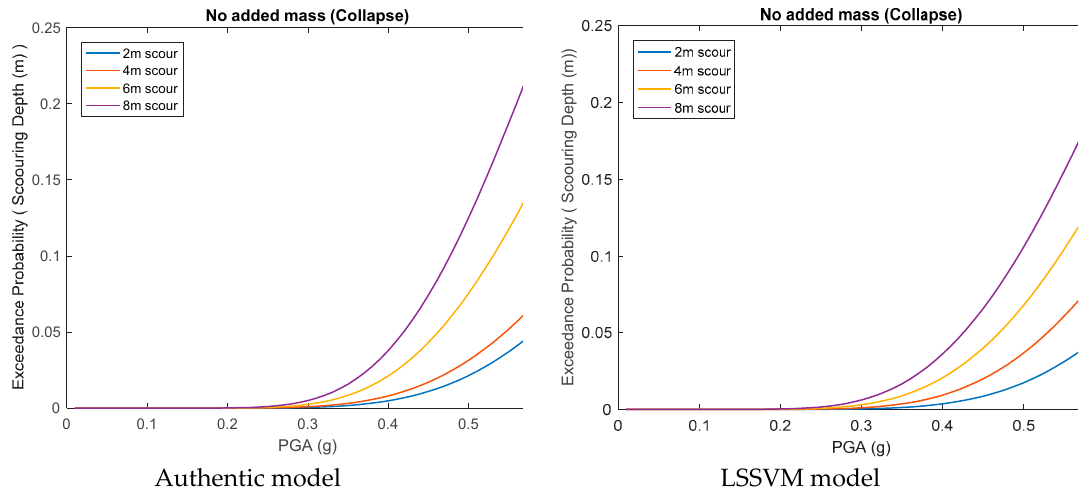
Figure 20. Fragility curves using authentic and LSSVM models.